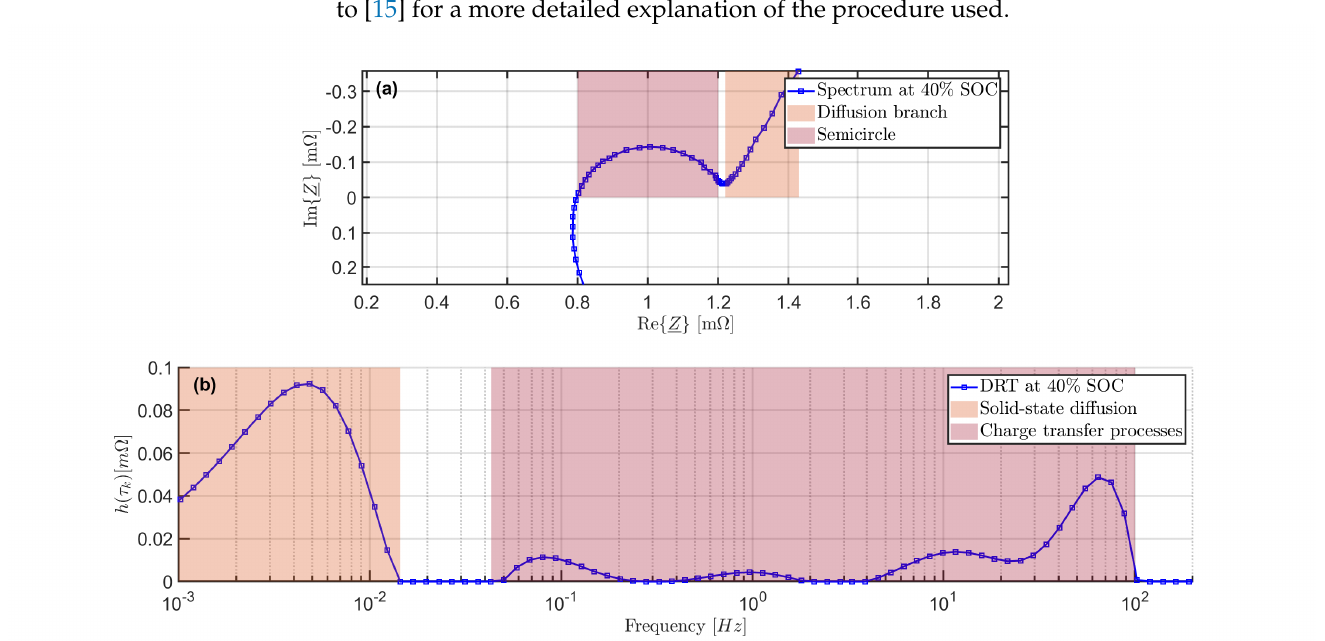
Figure 1. ( a ) Impedance spectra of pristine cell at 40% SOC. ( b ) Corresponding